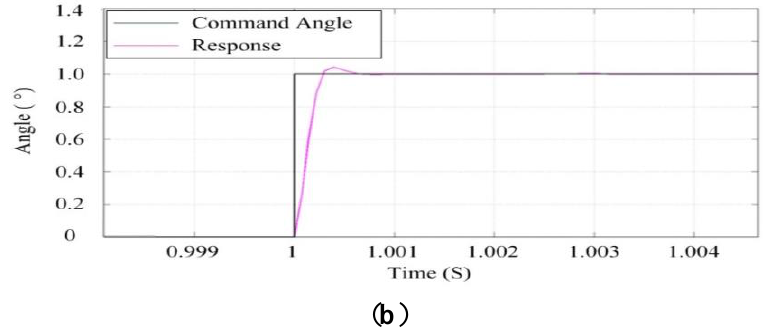
Figure 13. Step response of co-simulation: ( a ) the azimuth gimbal; ( b ) the pitch gimbal. The black curve represents the set angular position and the purple curve is the response of the ISP.